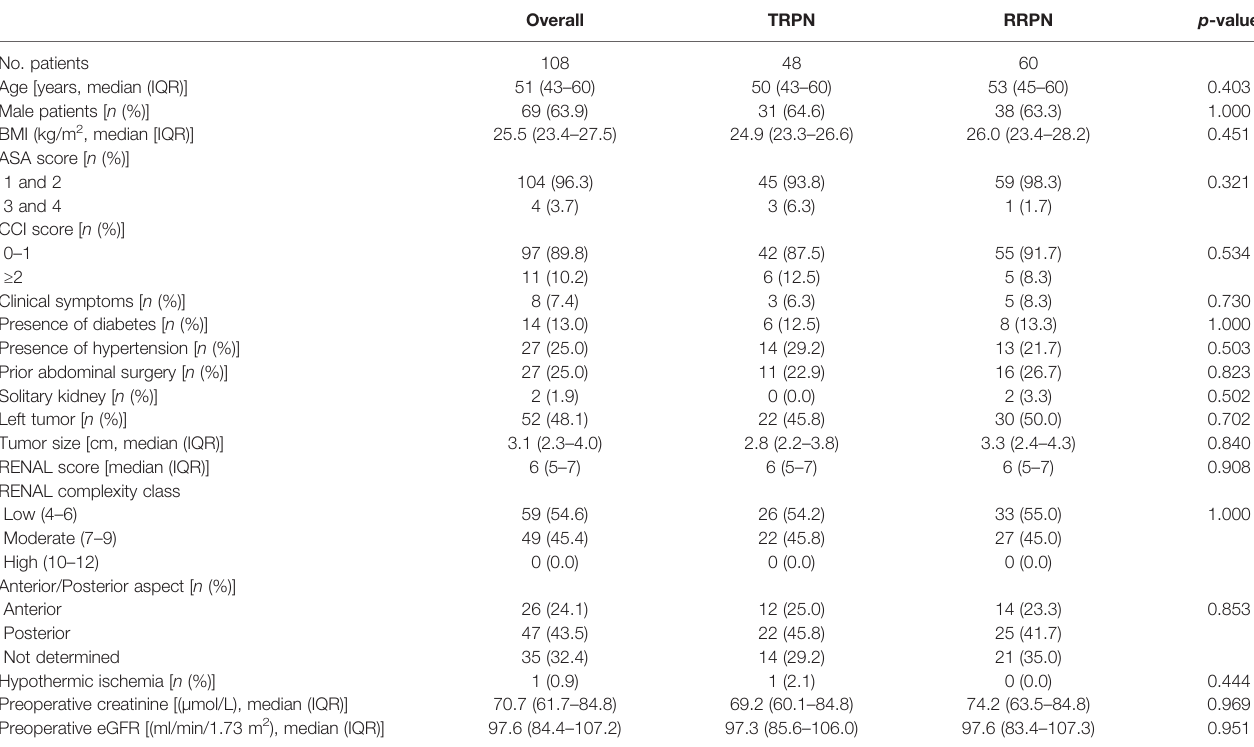
TABLE 1 | Patients ’ demographics and tumor characteristics.